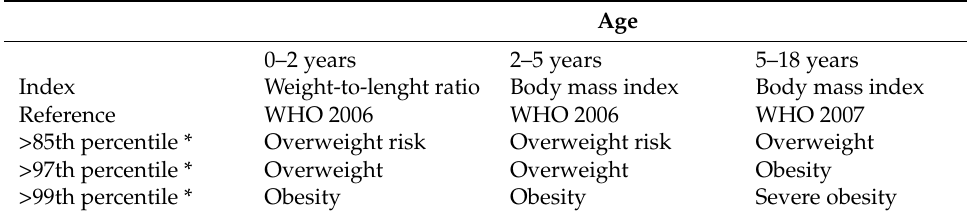
Table 1. Obesity and overweight diagnostic criteria in